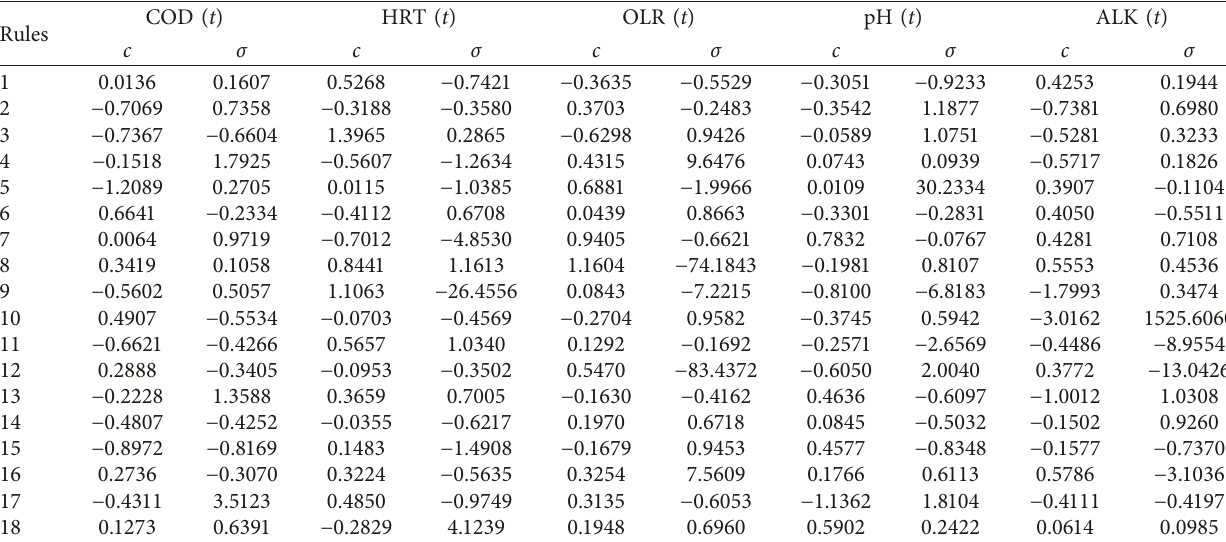
Table 1: Parameters of the FNNCOD.